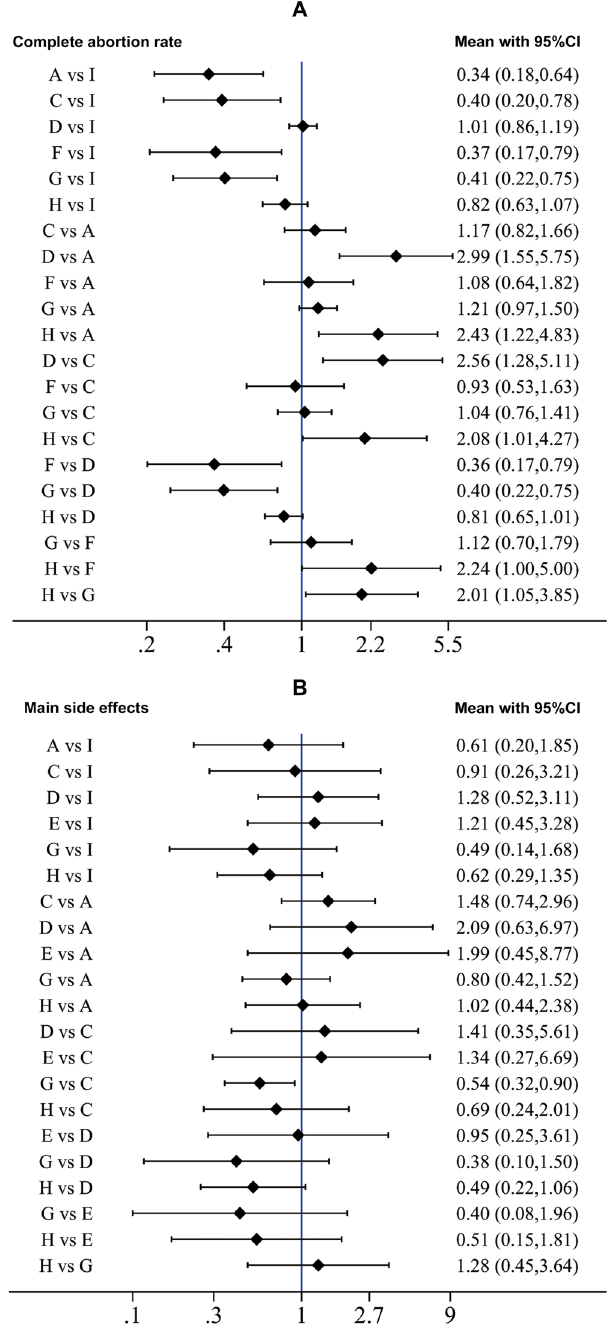
Figure 3. Network meta-analysis of complete abortion rate within about 24 hours and main side effects. Interventions are sequenced as follows: A. Oral 400 ug; C. Sublingual 400 ug; D. Sublingual 600 ug; E. Sublingual 800 ug; F. Vaginal 200 ug; G. Vaginal 400 ug; H. Vaginal 600 ug; I. Vaginal 800